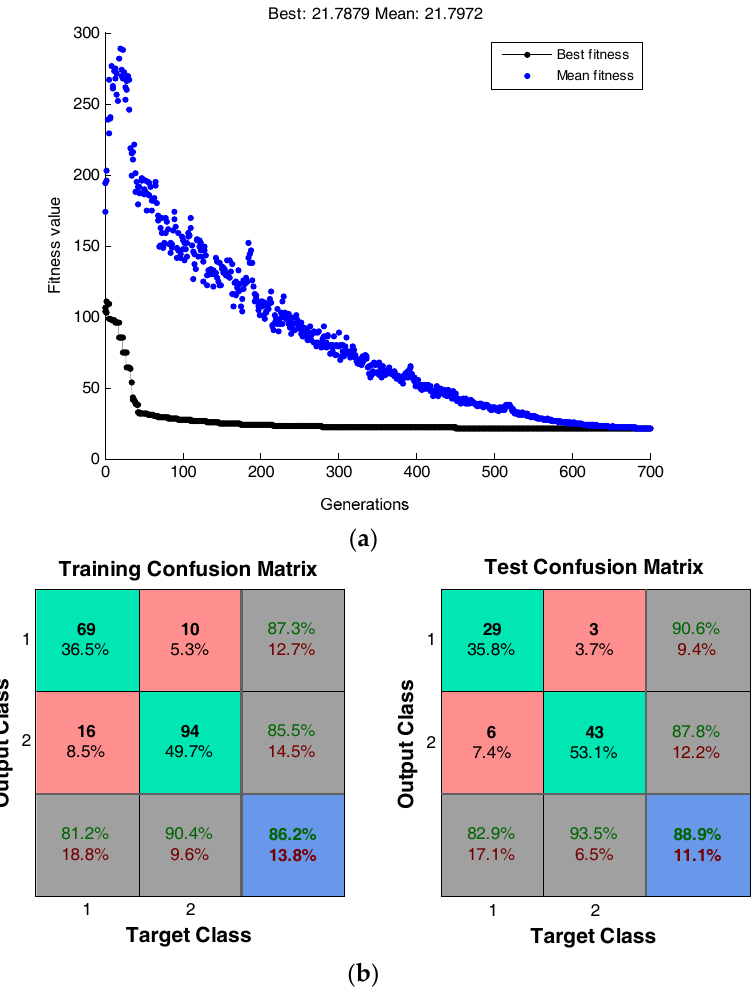
Figure 8. Simulation results of the GA-BEL on the Heart dataset. ( a ) Fitness curve during evolution; ( b ) classification confusion matrix for training and testing samples.